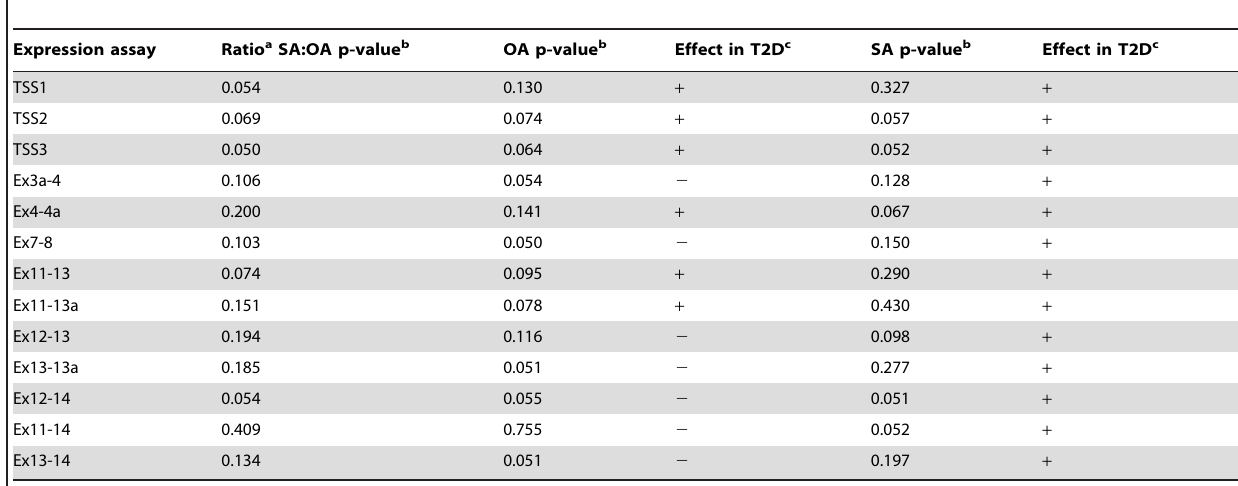
Table 2. Expression of TCF7L2 in omental and subcutaneous adipose tissues: comparison between T2D and control groups, 119 controls, 16 T2D